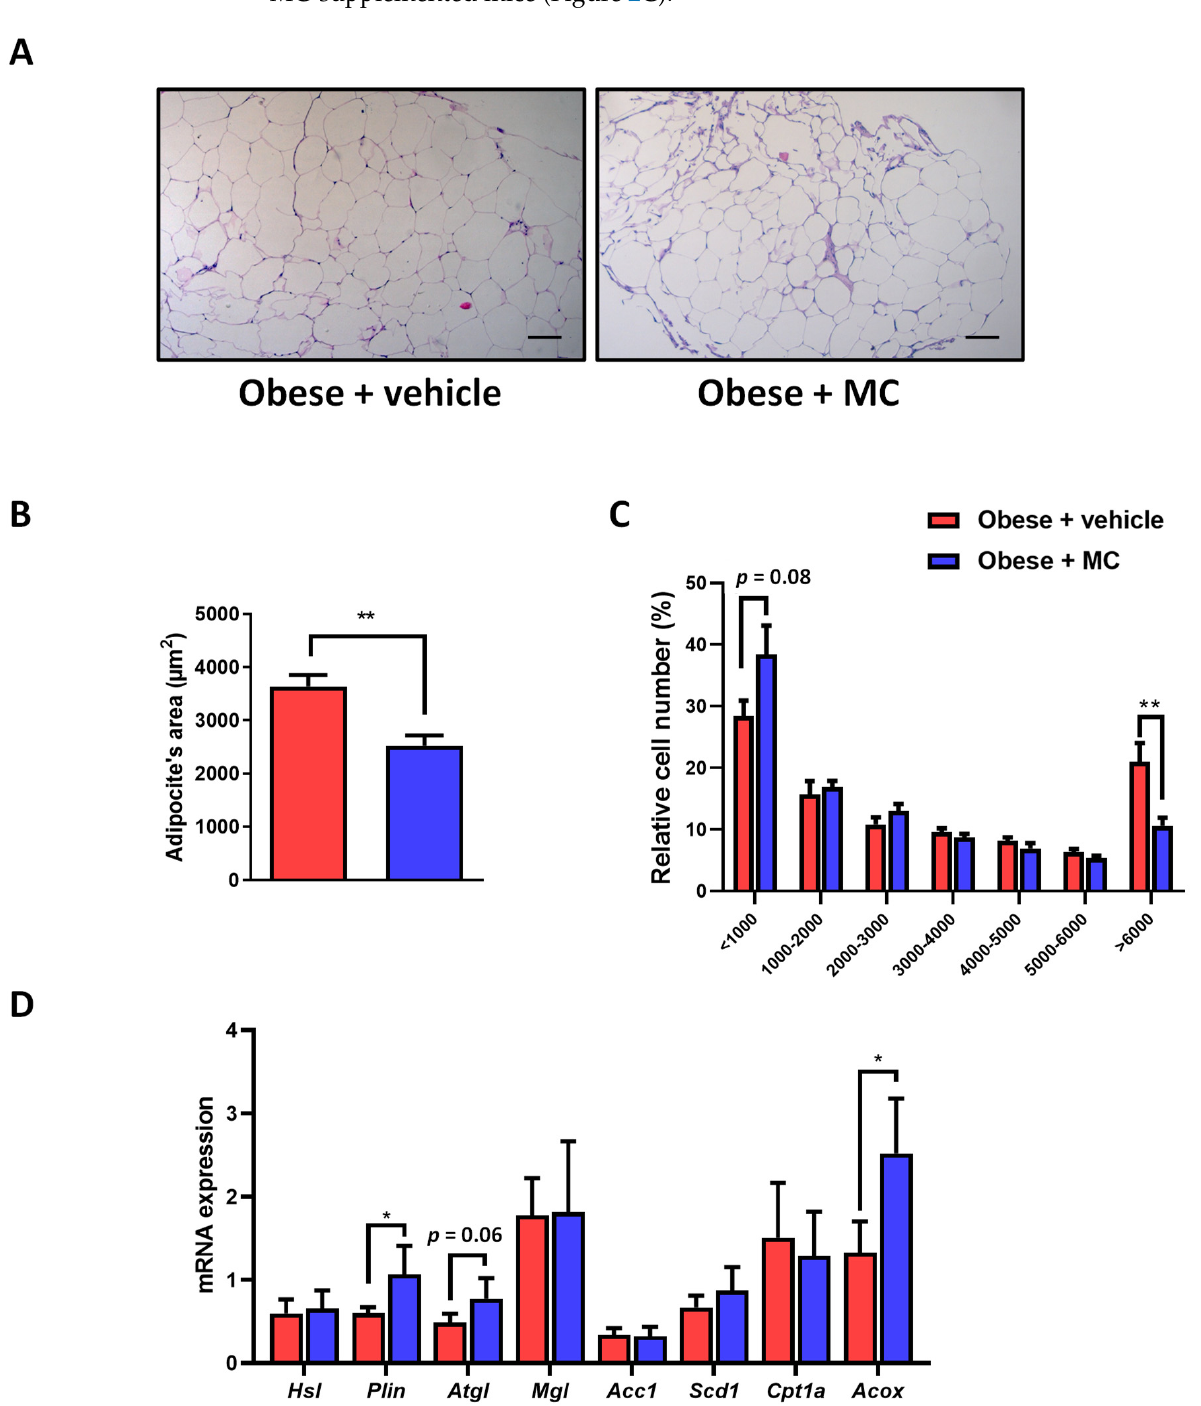
Figure 2. MC supplementation promotes a reduction in the adipocyte size, increasing lipolysis and fatty acid oxidation. Effects of treatments on adipocyte hypertrophy ( A ) Representative micro- graphs of hematoxylin–eosin stained EWAT sections from obese + vehicle and obese + MC groups (bar = 100 µm); ( B ) adipocyte area; ( C ) adipocyte size distribution; and ( D ) EWAT mRNA expression of genes related to lipolysis ( Hsl , Plin , Atgl and Mgl ), de novo lipogenesis ( Acc1 and Scd1 ), and fatty acid oxidation ( Cpt1a and Acox1 ). Data are mean ± SEM. * p < 0.05, ** p <